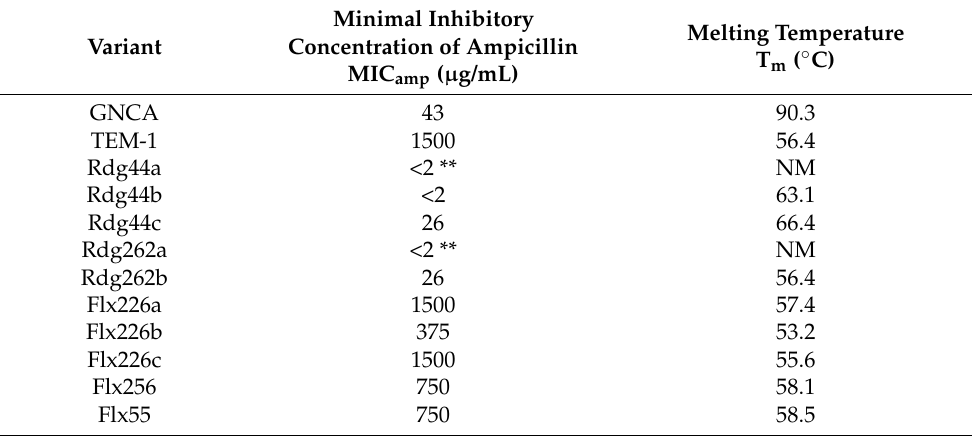
Table 1. Minimal Inhibitory Concentrations (MIC amp ) and melting temperatures of the TEM-1 variants.